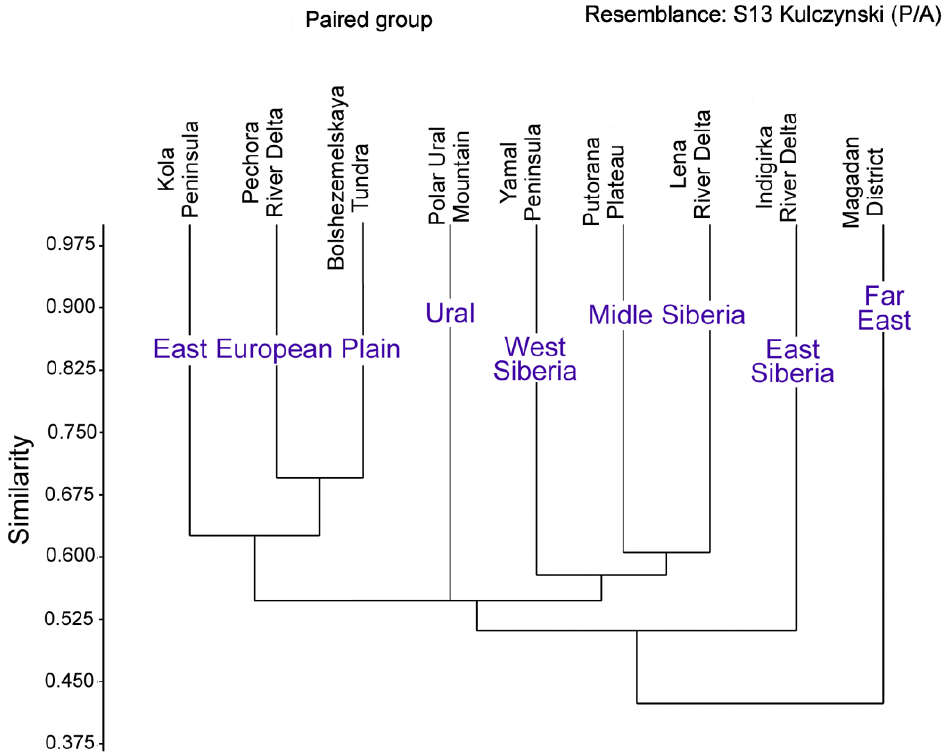
Figure 4. Dendrogram for hierarchical clustering of faunas of different regions of Subarctic and Arctic Eurasia regions.